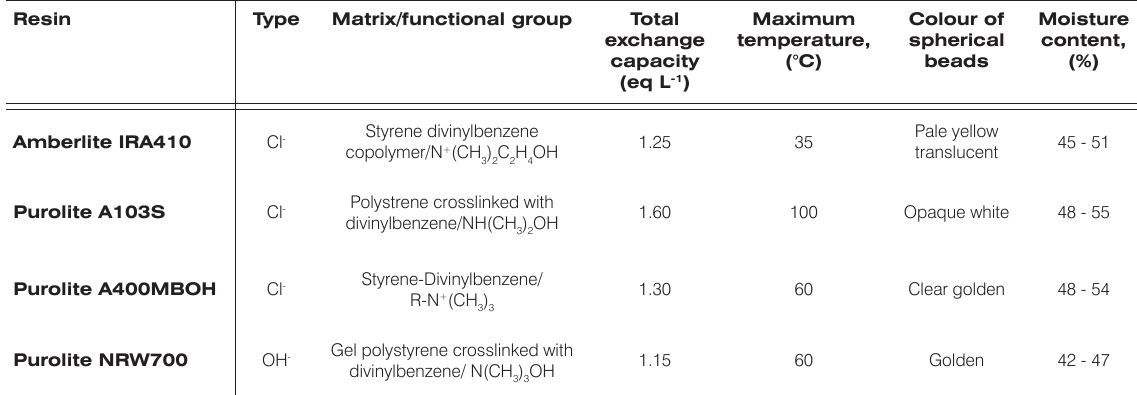
Table 1. Characteristics of the investigated anion exchangers (product data sheet).